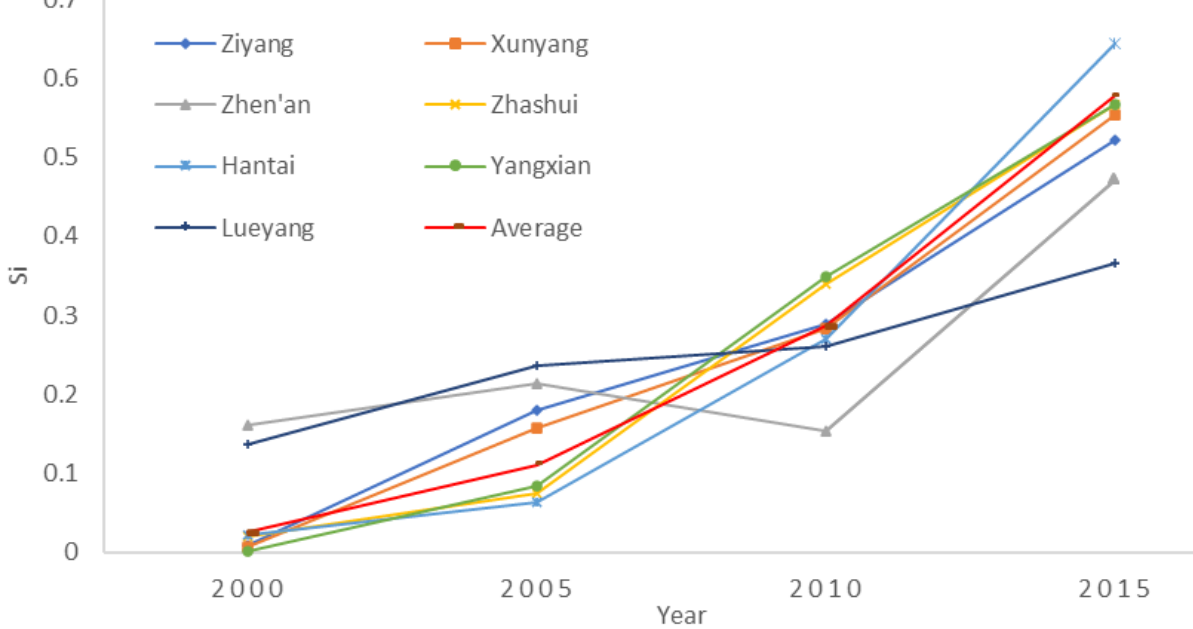
Figure 5. Socioeconomic development level of each county in the Qinba Mountains.